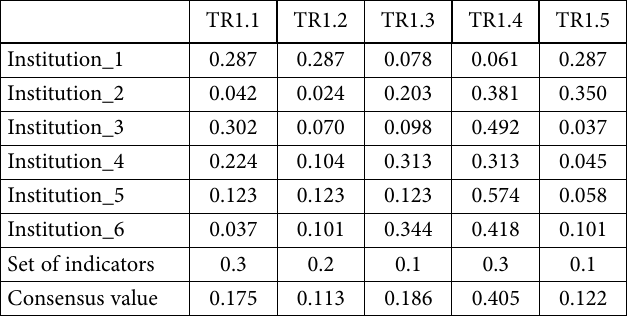
Table 3. Transparency-indicator weighting. Government board